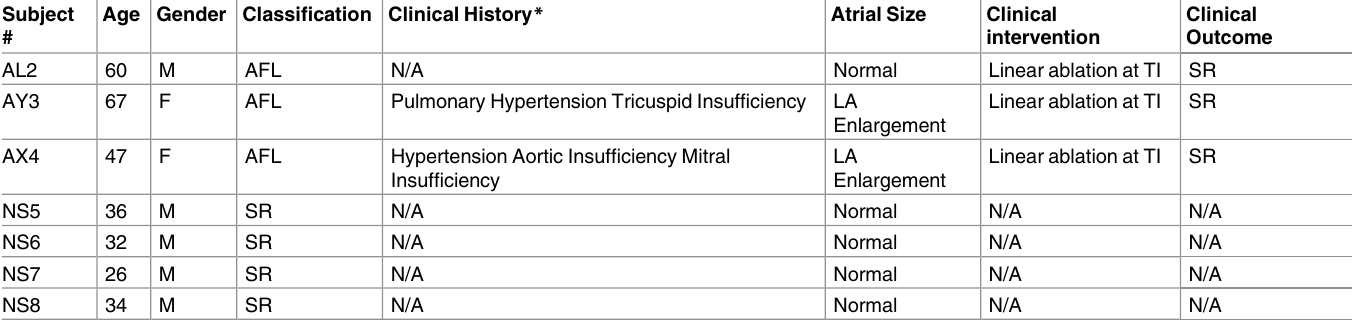
Table 1. Clinical characteristics of the study population. M = Male; F = Female; LA = Left atrium; RA = Right atrium; TI = Tricuspid isthmus; SR = Sinus rhythm. Subject